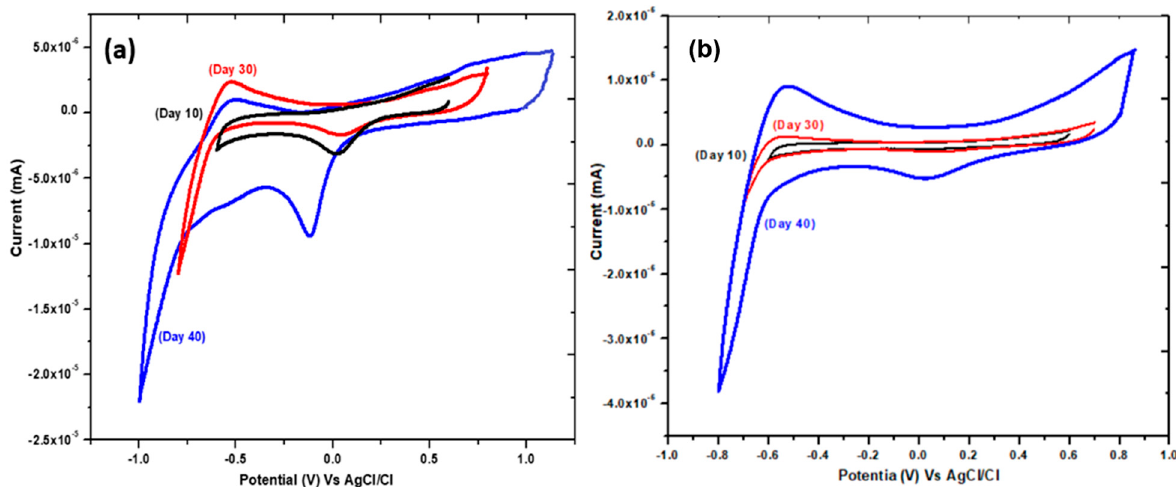
Figure 8. Cyclic voltammetry (CV) study of ( a ) GO ( b ) GO-PANI anodes at different time intervals during BMFCs opera- tion.